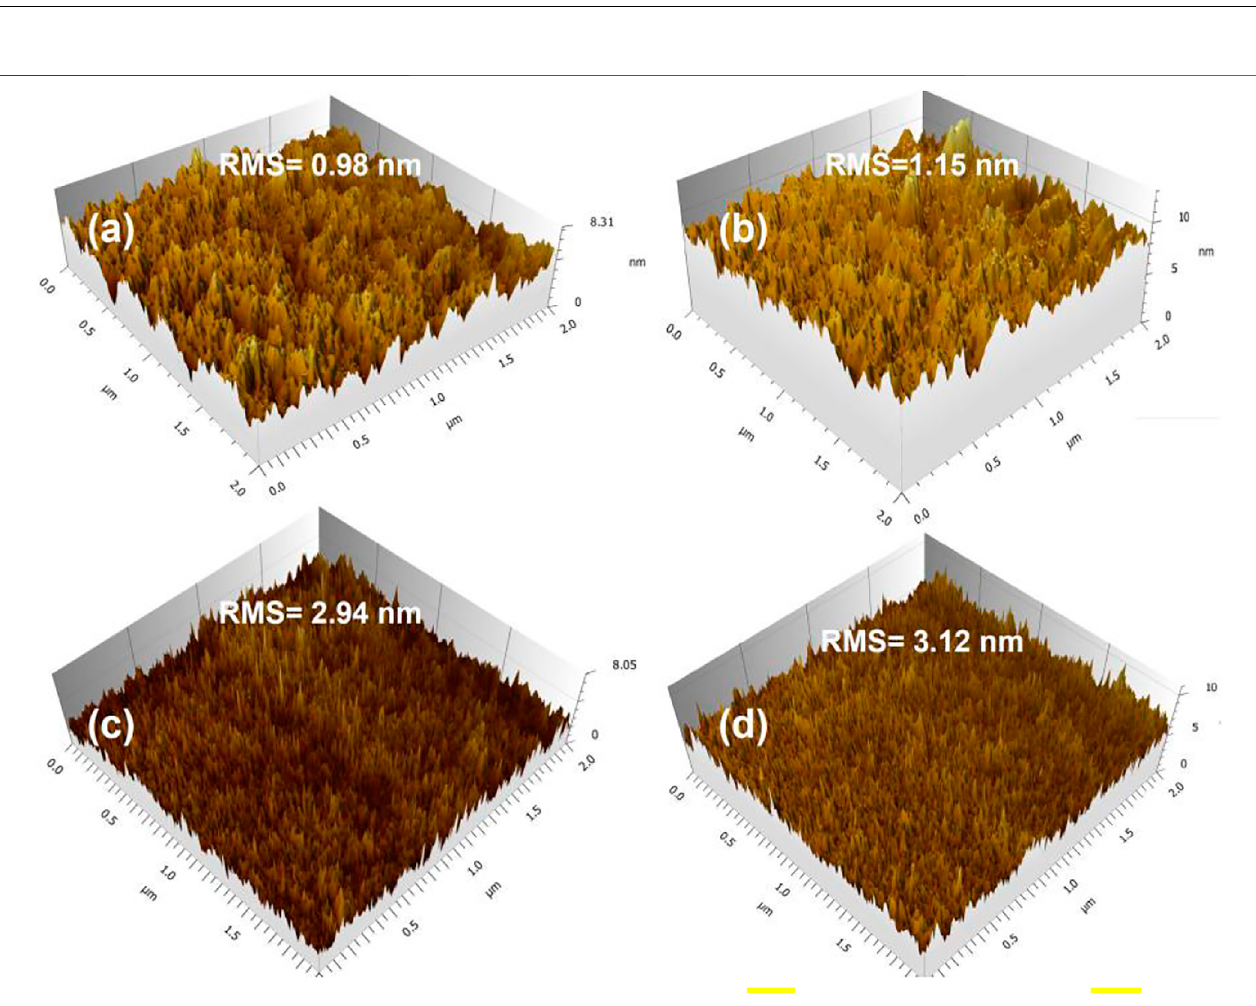
FIGURE 5 | 3D AFM topography of (A) PBDTTT-E, (B) PTB7, (C) PBDTTT-E:PC 71 BM, and (D) PTB7:PC 71 BM active layers.